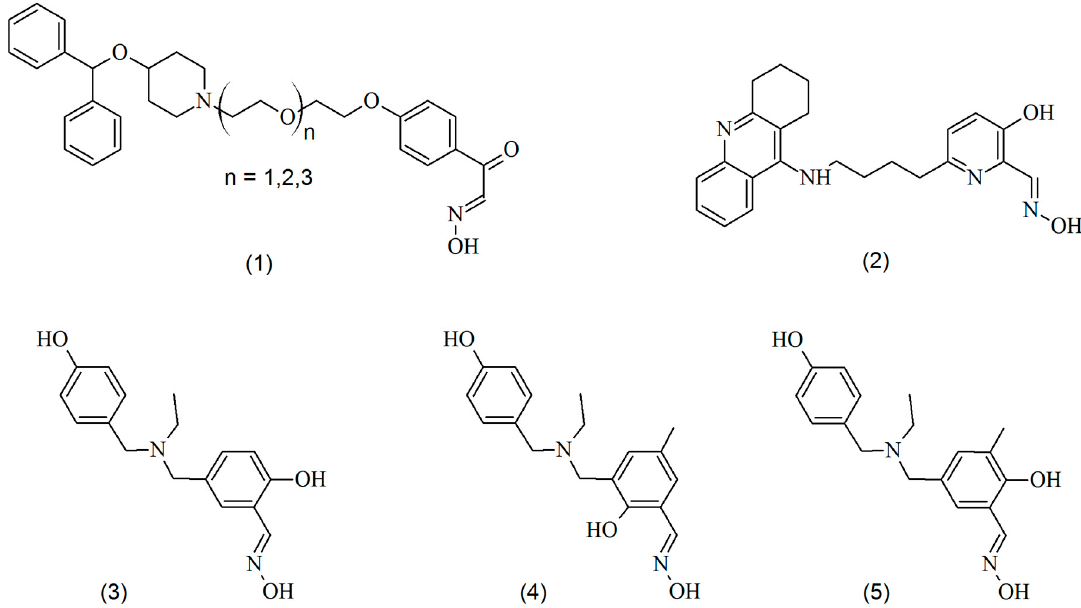
Figure 2. Structures of some neutral oximes reported in literature ( 1 [11], 2 [18] and 3 – 5 [22]).